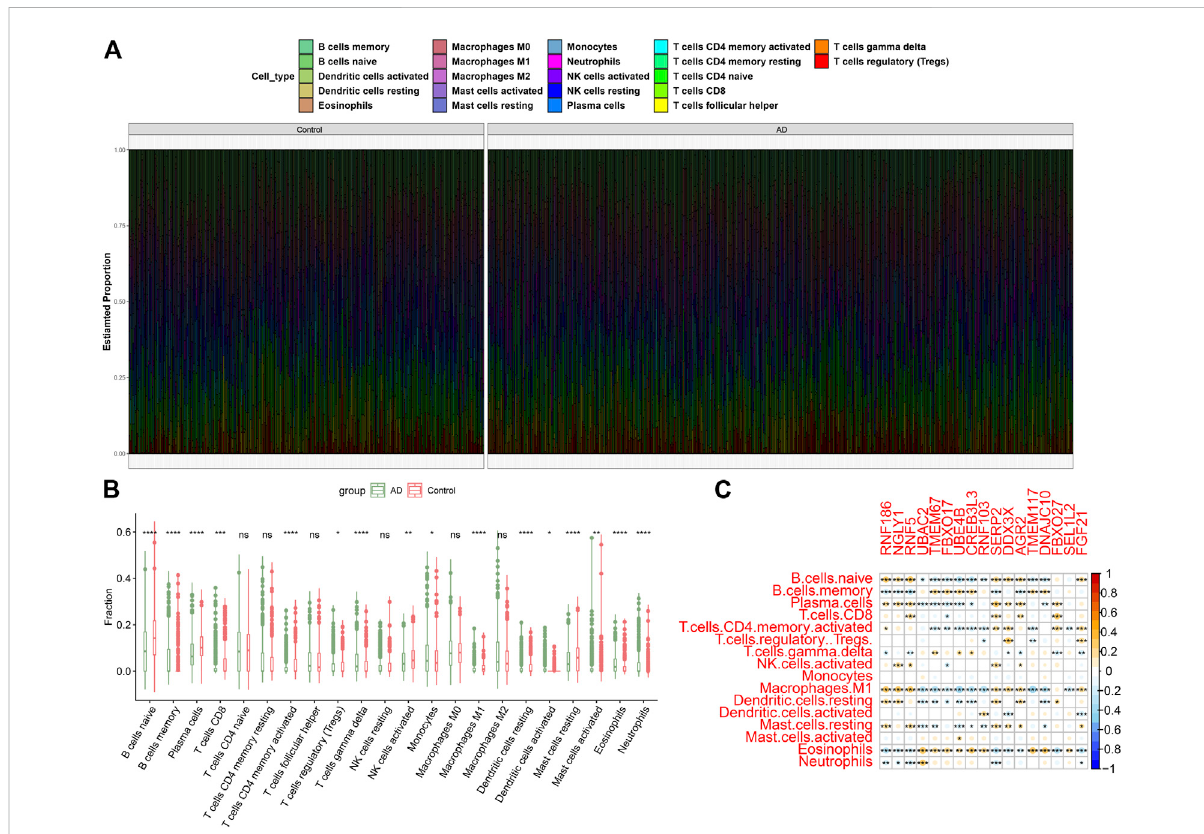
FIGURE 3 Identi fi cation of immune characteristics between AD and non-AD controls. (A) The relative proportions of 22 immune cells types between AD and normal individuals. (B) Representative boxplots show the differences of in fi ltrated immune cells between AD and normal individuals. * p < 0.05, ** p < 0.01,*** p < 0.001,**** p < 0.0001,ns,nosigni fi cance. (C) Correlation analysisbetween17 ERstress-related DEGsandin fi ltratedimmunecells.